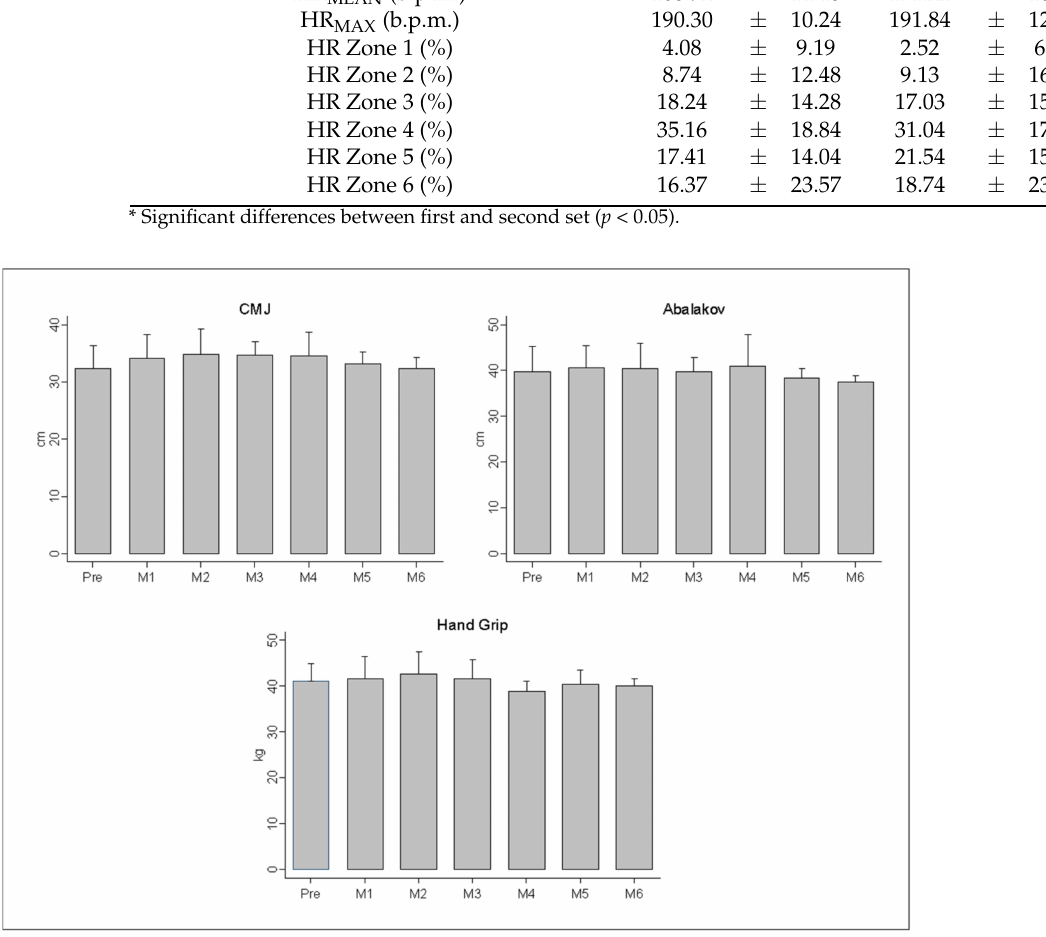
Figure 4. Evolution of the Countermovement Jumps (cm), Abalakov jump (cm), and handgrip (kg) values during the six matches of the tournament in women’s beach handball